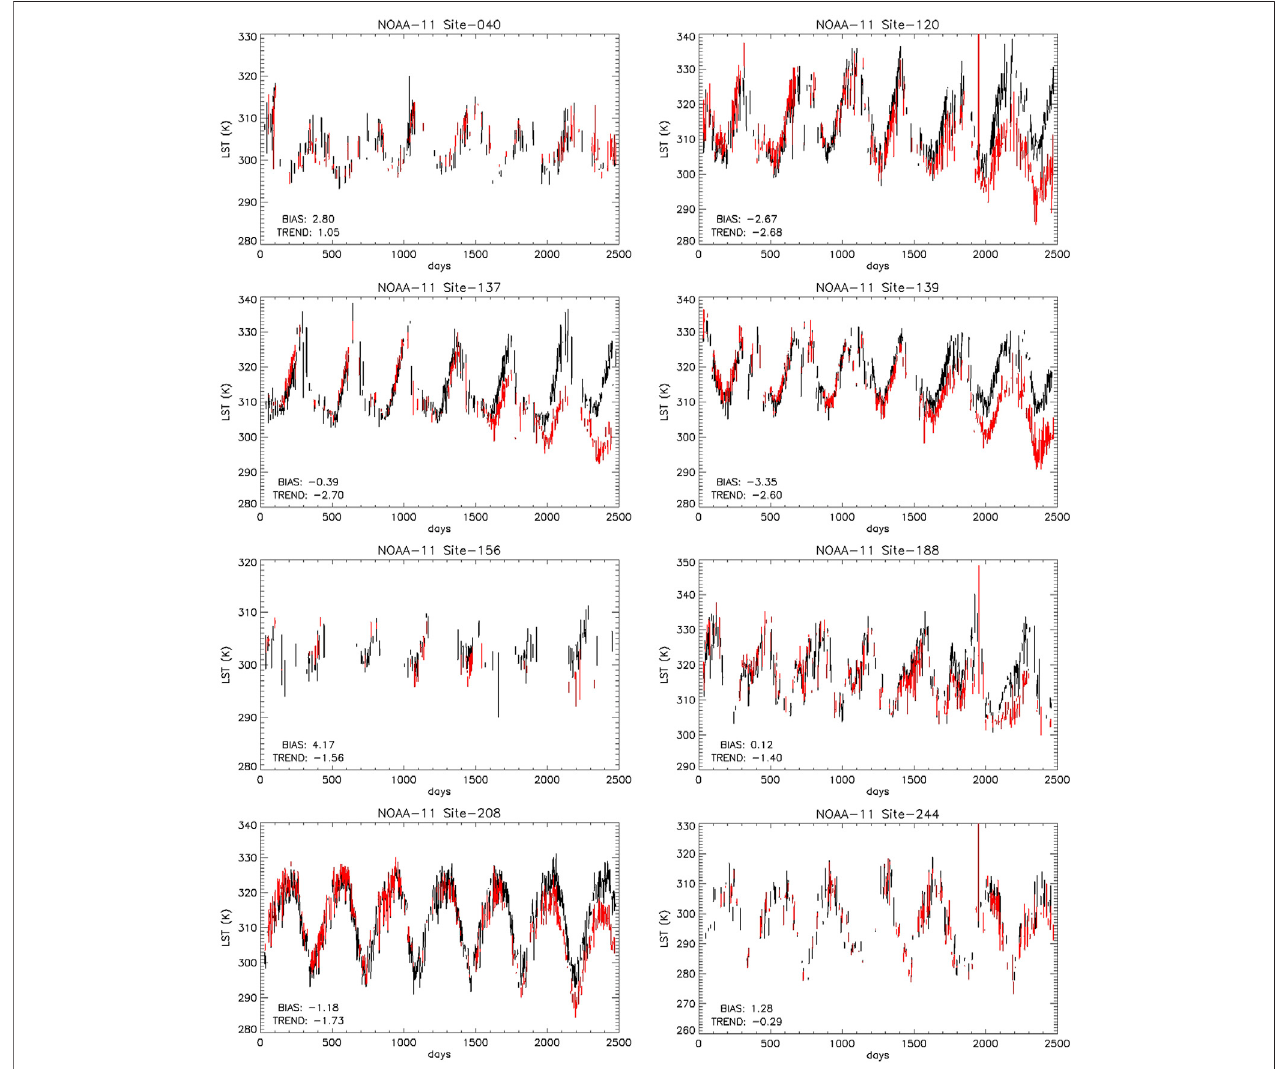
FIGURE 7 | Corrected time series for NOAA-11 platform for eight selected sites: reference (black) and Liu et al. (2019) corrected (red) time series along with the resulting bias and trend difference statistics.